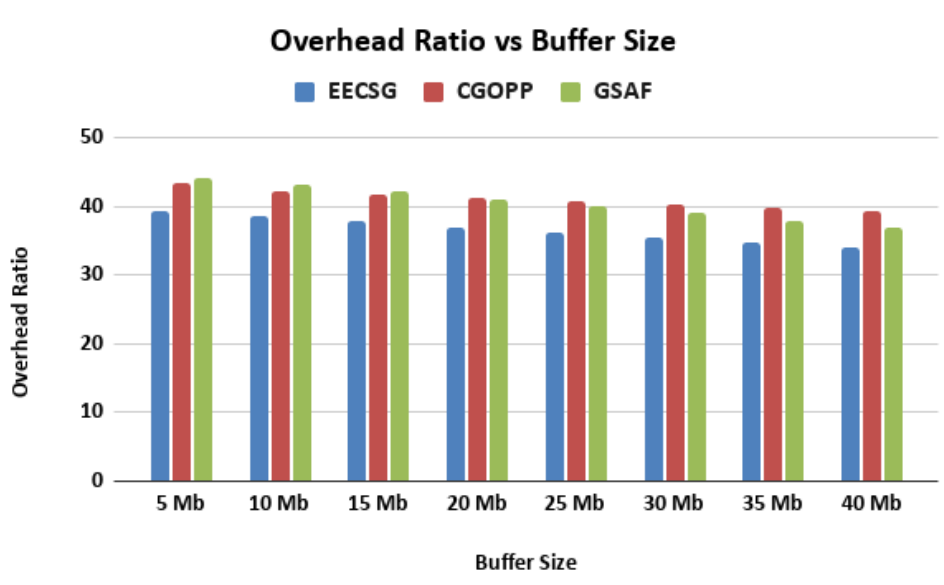
Figure 14. Overhead ratio vs. buffer size using real data mobility traces.